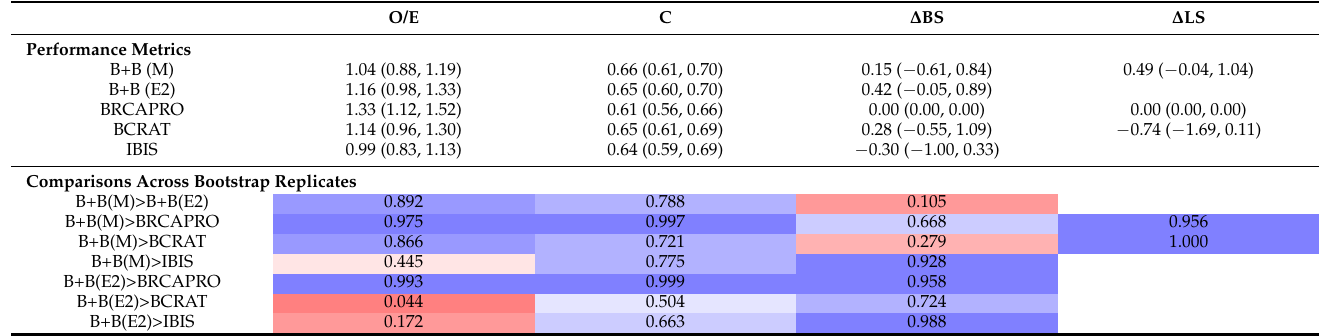
Table A5. Performance over follow-up period in entire CGN cohort. B+B: BRCAPRO + BCRAT. ∆ BS: % relative improvement in Brier Score compared to BRCAPRO. ∆ LS: % relative improvement in logarithmic score compared to BRCAPRO. The “Comparisons Across Bootstrap Replicates” section shows pairwise comparisons involving the combination models across 1000 bootstrap replicates of the validation dataset; the row for A > B shows the proportion of bootstrap replicates where model A outperformed model B with respect to each metric. Proportions > 0.5 are highlighted in blue (with darker shades of blue for higher proportions) and proportions ≤ 0.5 are highlighted in red (with darker shades of red for lower proportions). O/E C ∆ BS